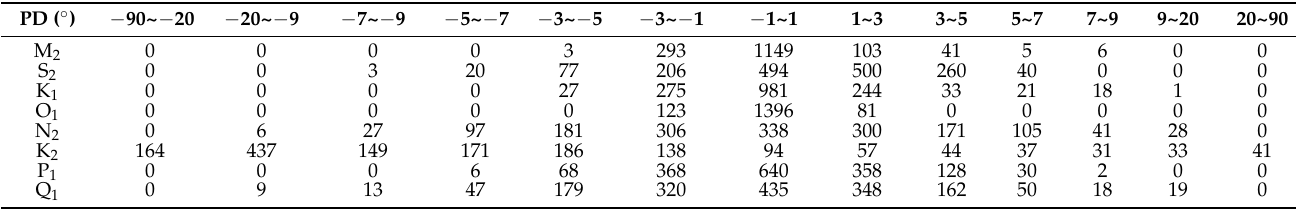
Table A2. Distribution of phase difference (PD) before and after the MVC of eight major tidal constituents in the South China